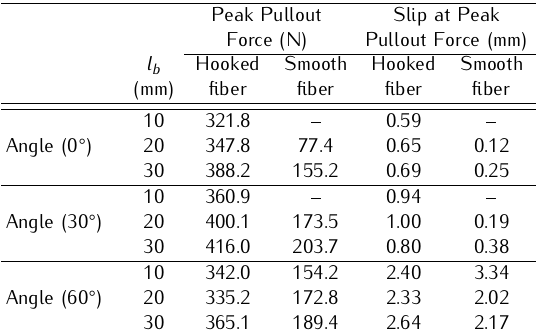
Table 4. Experimental results from the Cunha